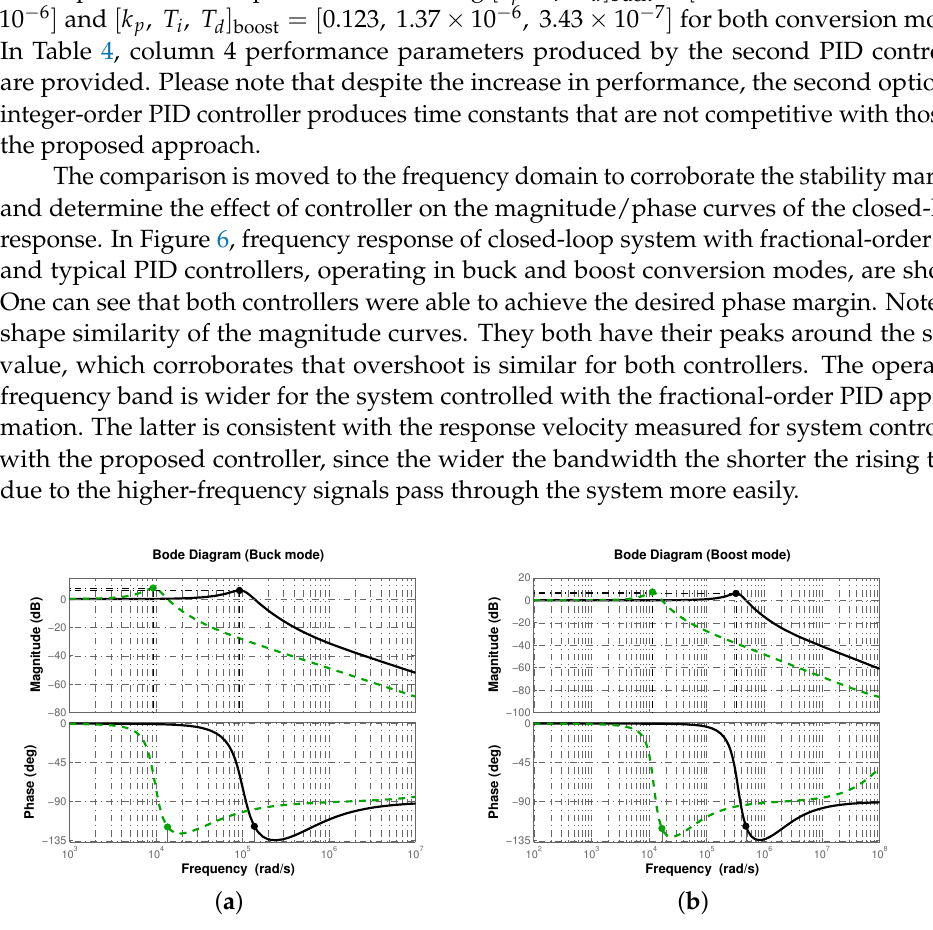
Figure 6. Frequency response of closed-loop system for both ( a ) buck and ( b ) boost conversion